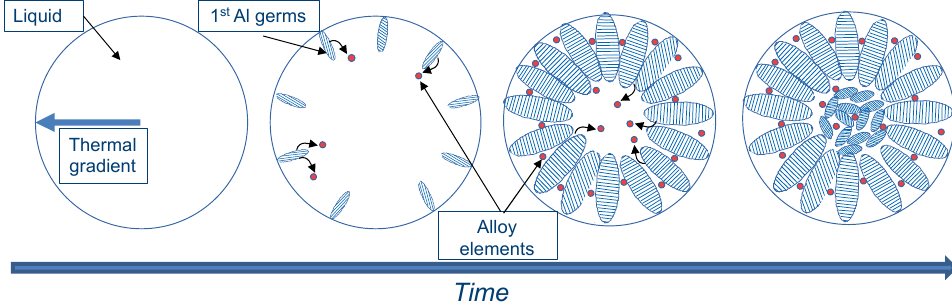
Fig. 7. S Schematic view of the mechanism occurring during particle solidification and bringing to the segregation of alloy elements at grain boundaries. Solid Al cellule nucleation and growth are shown in blue, alloy elements in red